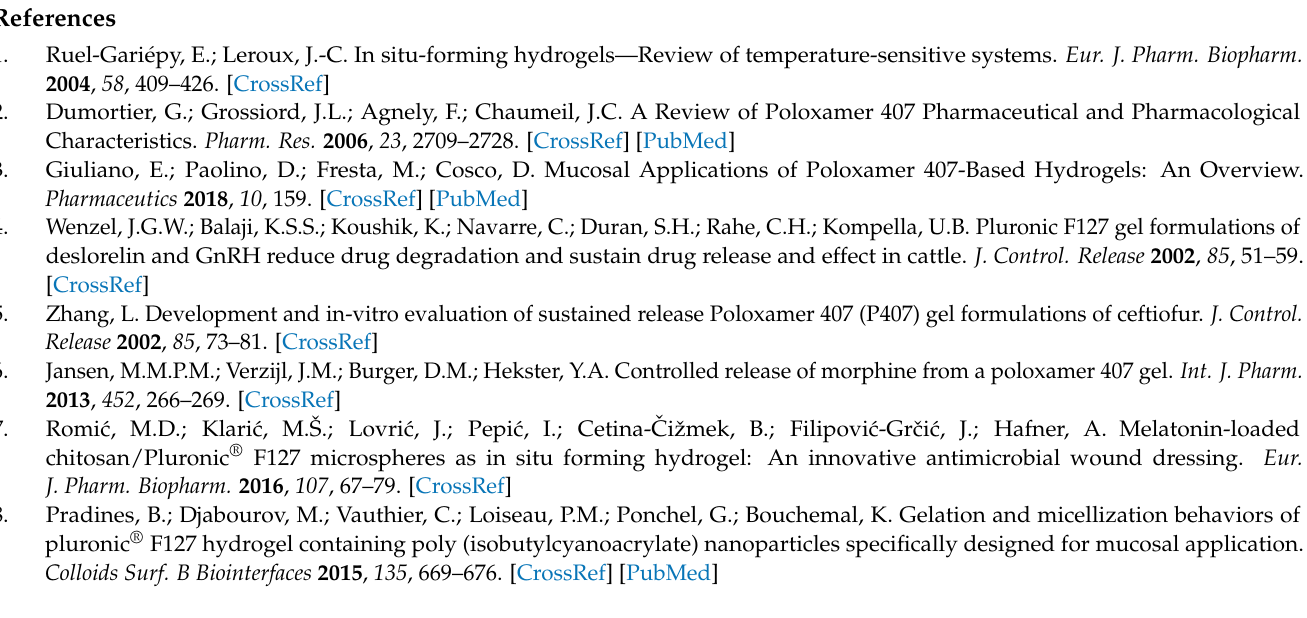
Table 1 in the paper. Means, ± std. error, ± 95% confidence interval; n = 3; Figure S2. Pseudoplasticity indices at 20 ◦ C. Means, ± std. error, ± 95% confidence interval; n = 3; Figure S3. Pseudoplasticity indices at 25 ◦ C. Means, ± std. error, ± 95% confidence interval; n = 3; Figure S4. Pseudoplasticity indices at 37 ◦ C. Means, ± std. error, ± 95% confidence interval; n = 3; Figure S5. Mixtures of P17 and chosen natural oils, pre- and post-emulsification. Photographed in identical light conditions; Figure S6. Mixtures of P17 and chosen semisynthetic oils, pre- and post-emulsification. Photographed in identical light conditions; Figure S7. P17–ORC50 emulsion compared with IBU–loaded ORC emulsions; Figure S8. Syringeability study results in P17–ORC50–IBU10 emulsion. Models and box-and-whiskers plots were calculated upon net extrusion force, while raw (gross) data was also shown for a better consideration of the actual force needed to move the plunger. Means, ± std. error, ± 95% confidence interval; n = 3; Figure S9. Extrusion process observed at the needle-end in syringeability study: (A) drop-wise flow in a blank emulsion; (B) formation and detachment of elongated drops in a gelated, IBU-loaded emulsion. Needle: 20 G (0.9 mm × 40 mm); flow rate: 0.5 mL/min; temperature: 25 ◦ C; Table S1. Specification of needles used in the syringeability study; Table S2. Complete results of the drug release study. IBU released, µ g/mm 2 . Means ± sd, n = 6; Table S3. Complete results of segmented-fit modelling of the drug release kinetics; summary of adjusted-RSS values against proposed breakpoints. Values in bold are the minima found among the sums of Adjusted-RSS from non-linear and linear fits. K–P = Korsmeyer–Peppas model: y = k × x n ; Linear: y = k × x